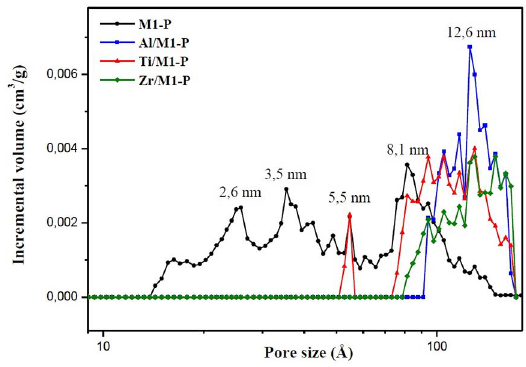
Figure 10. Pore distribution curves for the samples M1 incorporated with heteroatoms and functionalized with